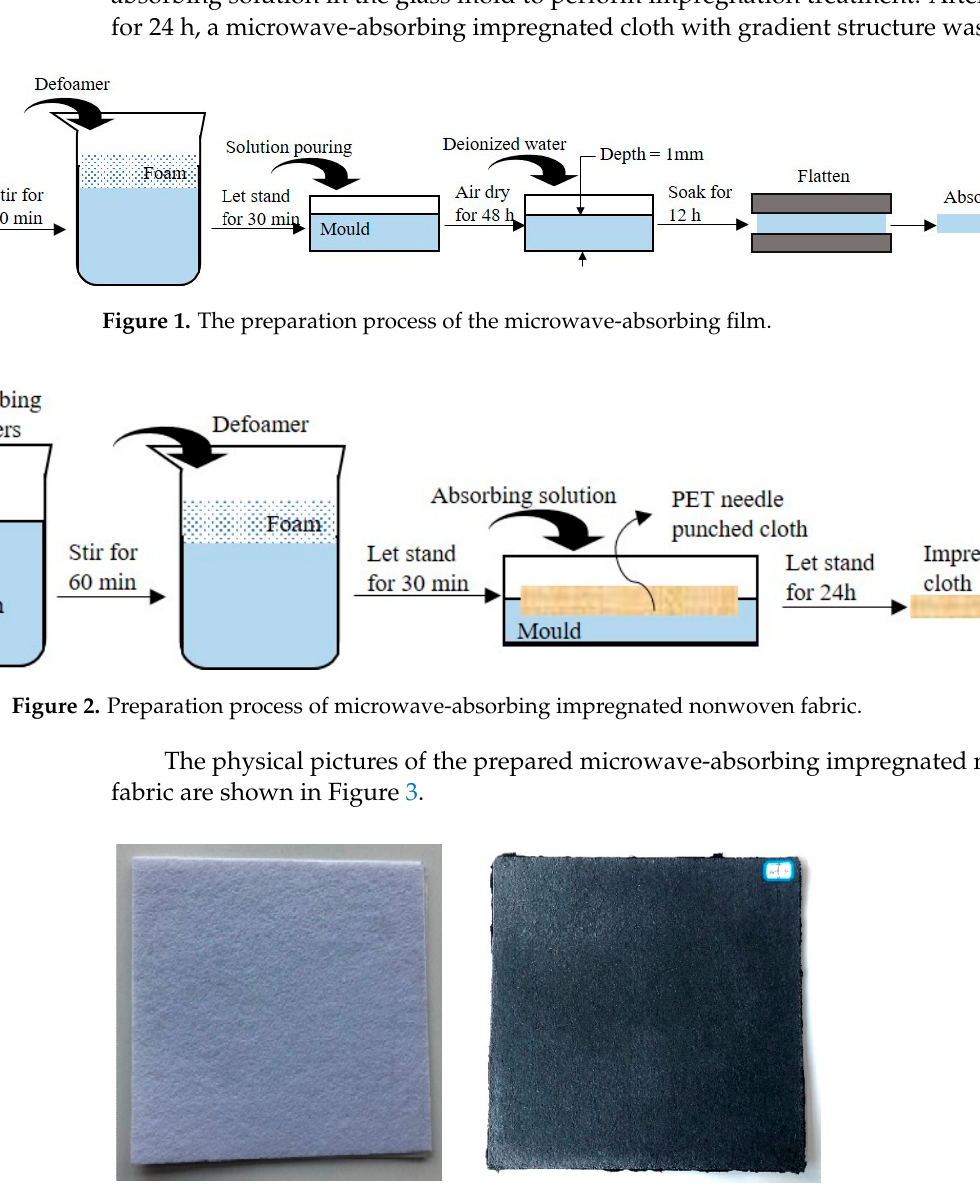
Figure 1. The preparation process of the microwave-absorbing film.